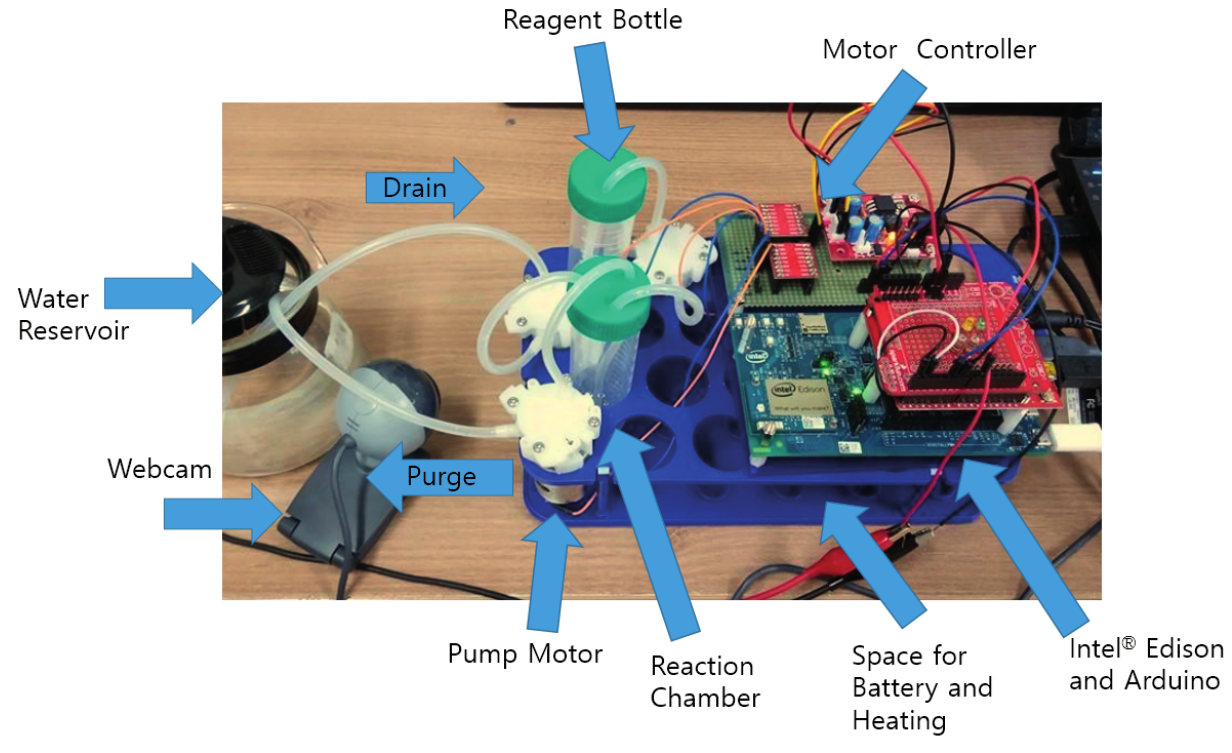
Figure 5. Assembled sensor node on the test